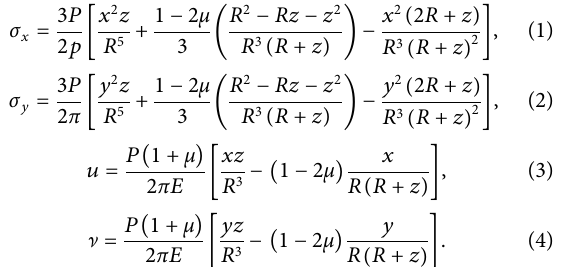
FIGURE 1 The sketch map of punctate load model ’ s coordination